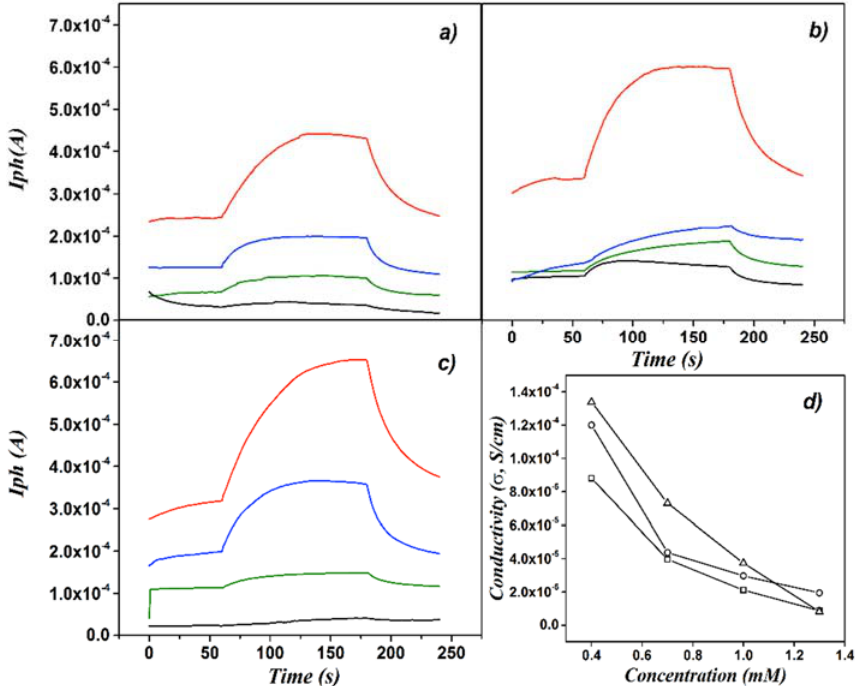
Figure 10. Photocurrent of PVA films with self ‐ assembled chitosan ‐ AuNPs/SWCNT ‐ COOH nanostructures films at the different HAuCl 4 ∙ 3H 2 O concentrations: (  ) 0.4, (  ) 0.7, (  ) 1.0 and ( 